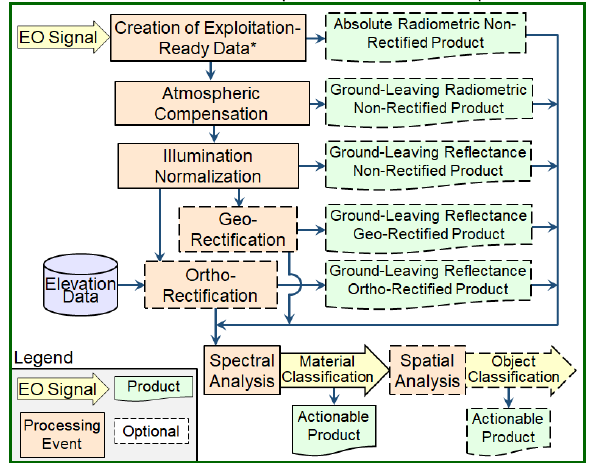
Figure 4 . Example exploitation flow for geoscience data.